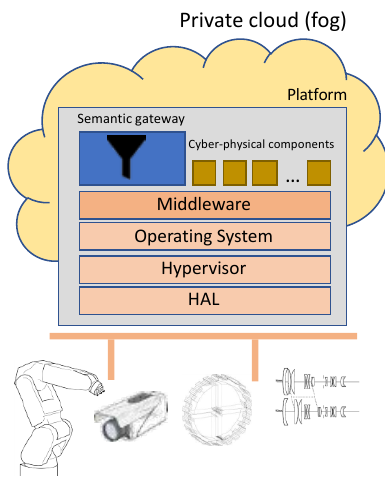
Figure 2. Cyber-physical system level.